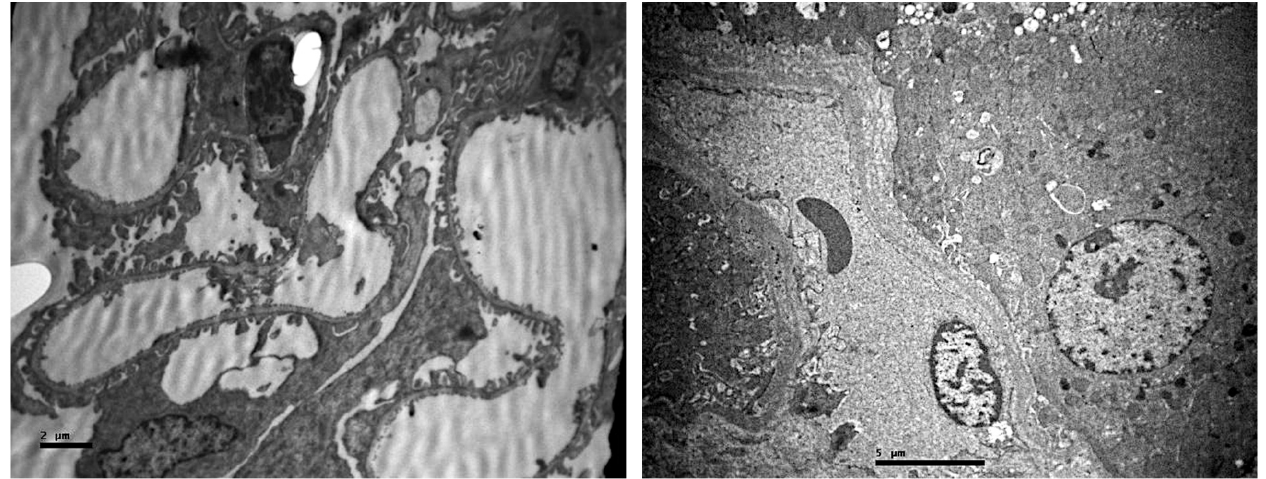
Figure 17. ( Left ) Normal renal corpuscle (2 μ ). ( Right ) Normal renal connective tissue with normal capillaries. Normal renal tubules (5 μ ).